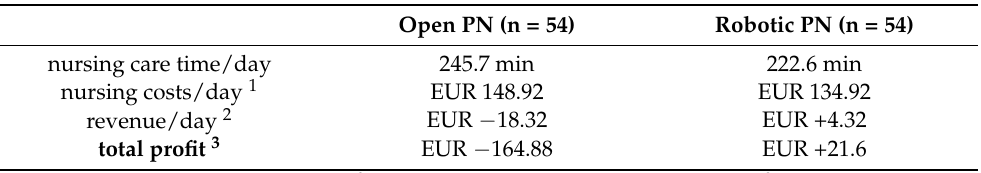
Table 4. Comparison of the revenue for nursing care of open vs. robot-assisted partial nephrectomies (PN) in the propensity-score-matched